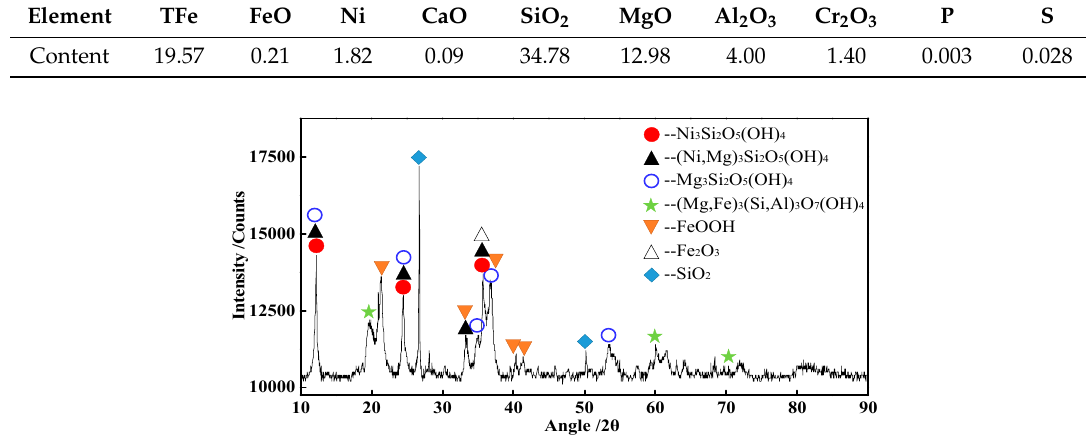
Table 1. Chemical composition of the laterite nickel ore (wt %). Table 2. Industrial composition of the coal (wt %).